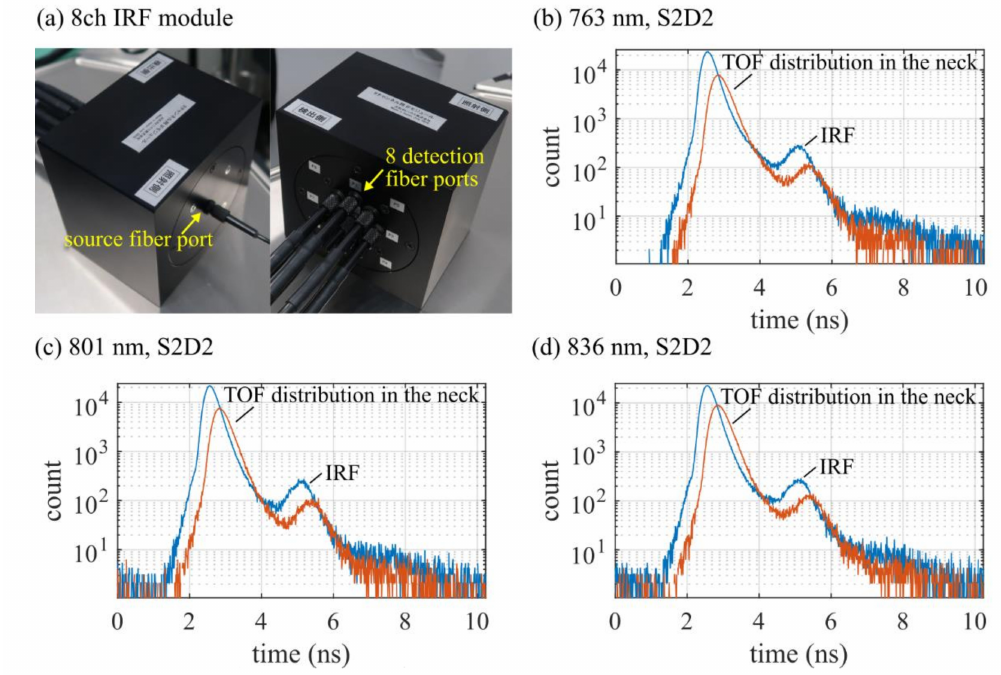
Figure 2. Instrumental response function (IRF) and time-of-flight (TOF) distribution in the neck. ( a ) 8ch IRF module; ( b ) IRF and TOF distribution at 763 nm of S2D2; ( c ) IRF and TOF distribution at 801 nm of S2D2; ( d ) IRF and TOF distribution at 836 nm of